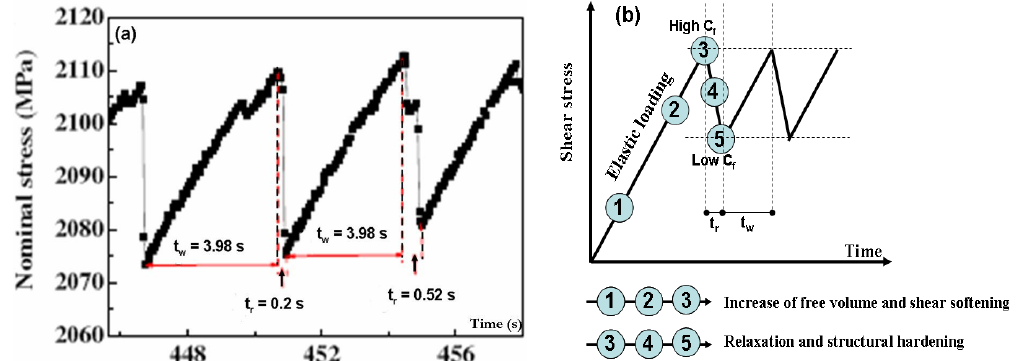
Figure 1. ( a ) Experimental stress ‐ time curve of deformed Zr ‐ based Bulk Metallic Glasses (BMG) showing typical serrations in time scale [24]; ( b ) The corresponding schematic illustration of successive serration events. C f is the flow defect concentration (free volume content), t r is the relaxation time (the stress drop time) and t w is the waiting time (the stress increasing time).